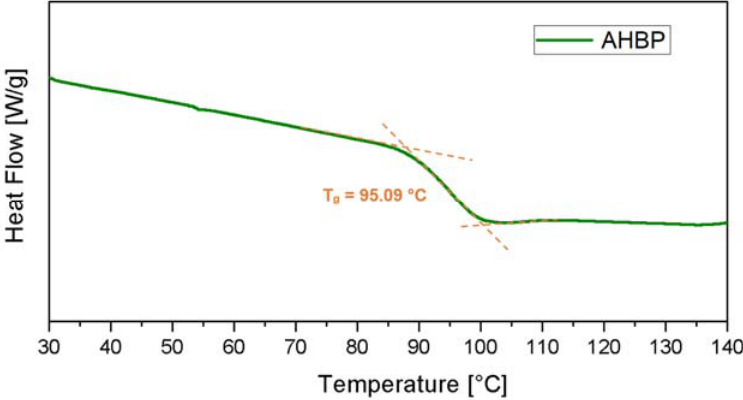
Figure 8. DSC curve of synthesized AHBP.